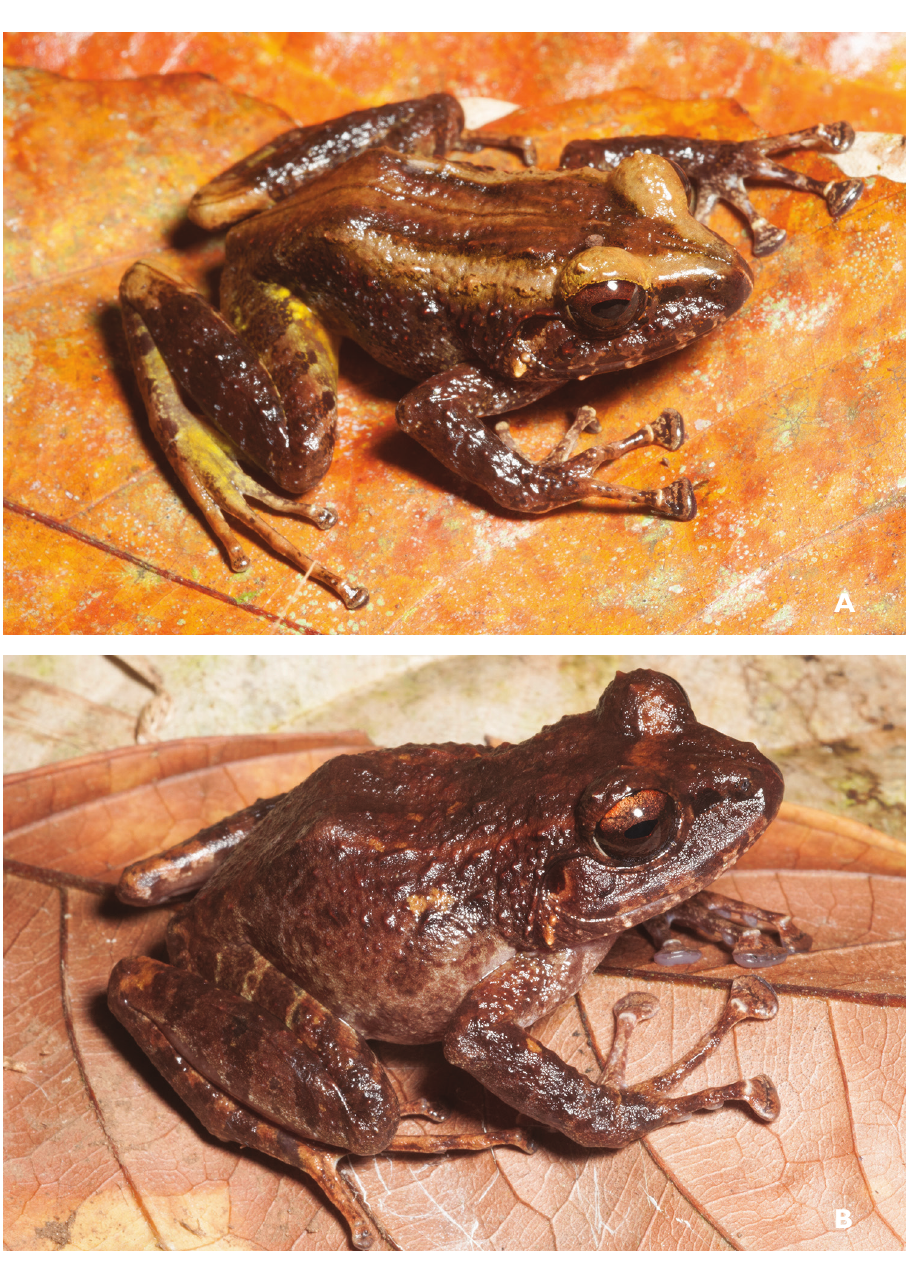
Figure 7. Platymantis rabori male ( A KU 334334) and female ( B KU 334335) from 900 masl, Mt. Lumot, Gingoog, Misamis Oriental Province. Photos: RMB.